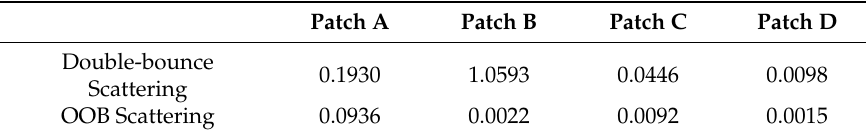
Table 4. Averaged magnitude of scattering power for UAVSAR